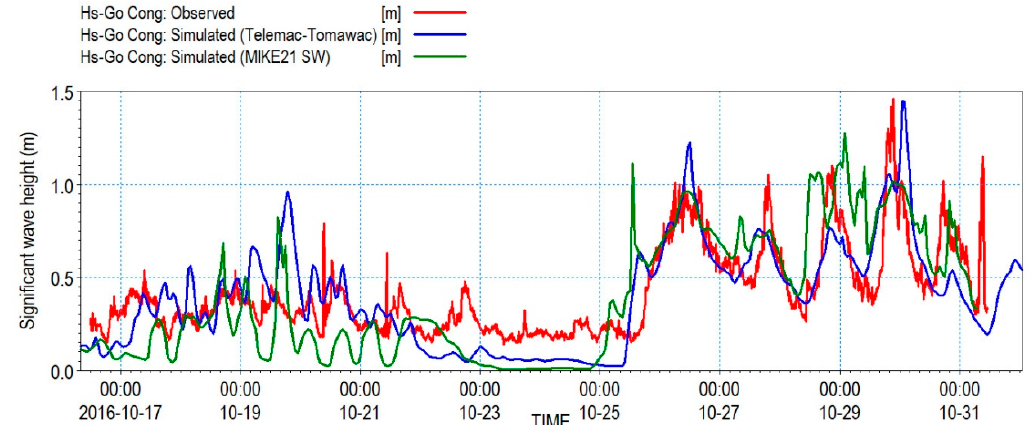
Figure 5. Wave model calibration (significant wave heights) at the observation site (16–31 October 2016).